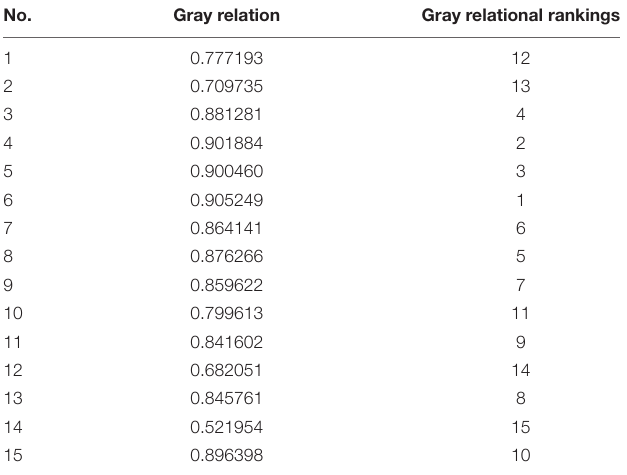
TABLE 2 | Gray relational grade of the peak with biofilm formation.